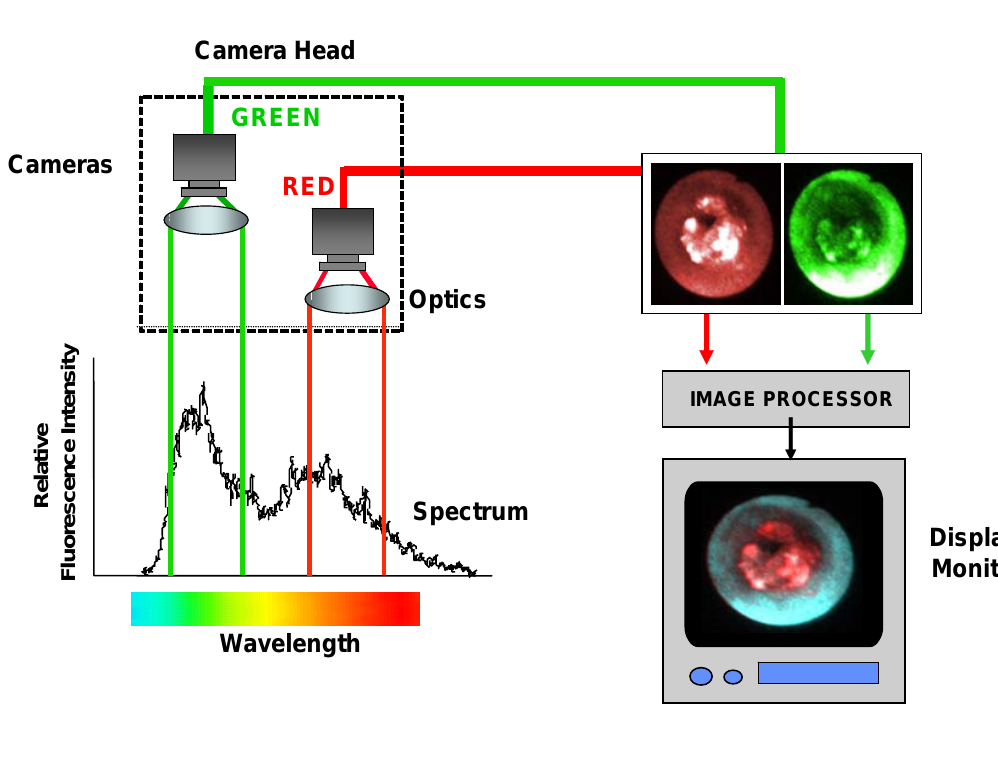
FIGURE 3. Schematic diagram illustrating the individual red and green fluorescence (reflectance) channels that make up the final displayed fluorescence pseudocolored